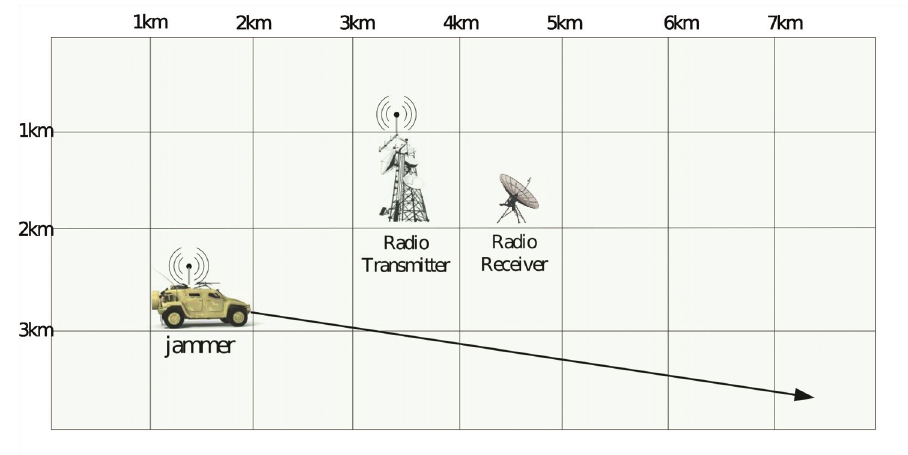
Fig 12. The end-to-end communication system under random electromagnetic interference.